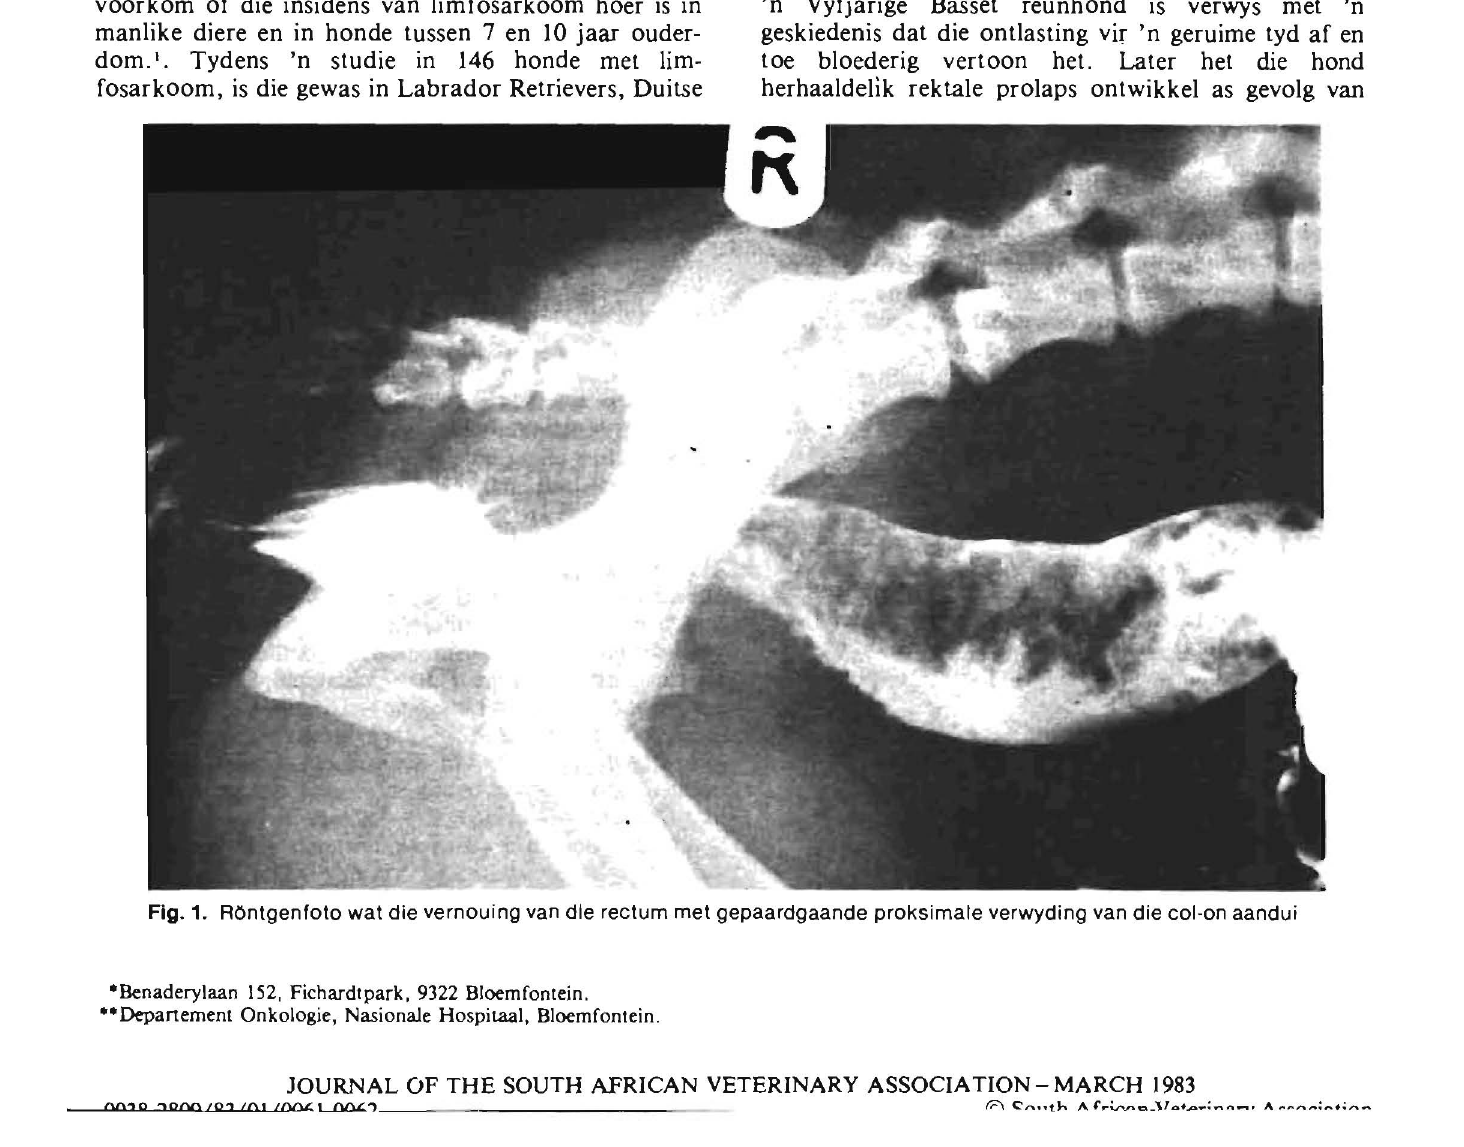
·Benaderylaan 152, Fichardtpark, 9322 Bloemfontein. uDepartement Onkologie, Nasionale Hospitaal,